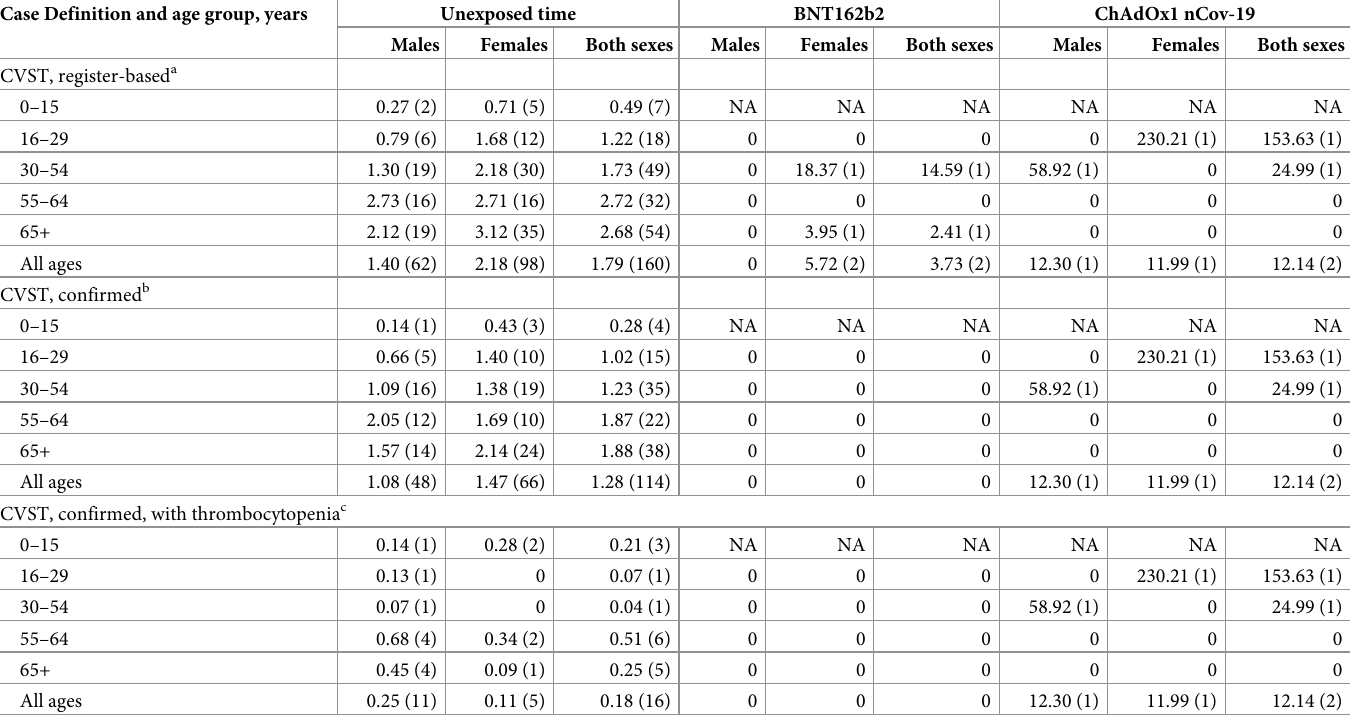
Table 1. Incidences per 28 days per million persons of cerebral venous sinus thrombosis and thrombocytopenia during the 28-day risk periods after COVID-19 vac- cinations and during the unexposed time preceding the vaccinations. Numbers of episodes provided in